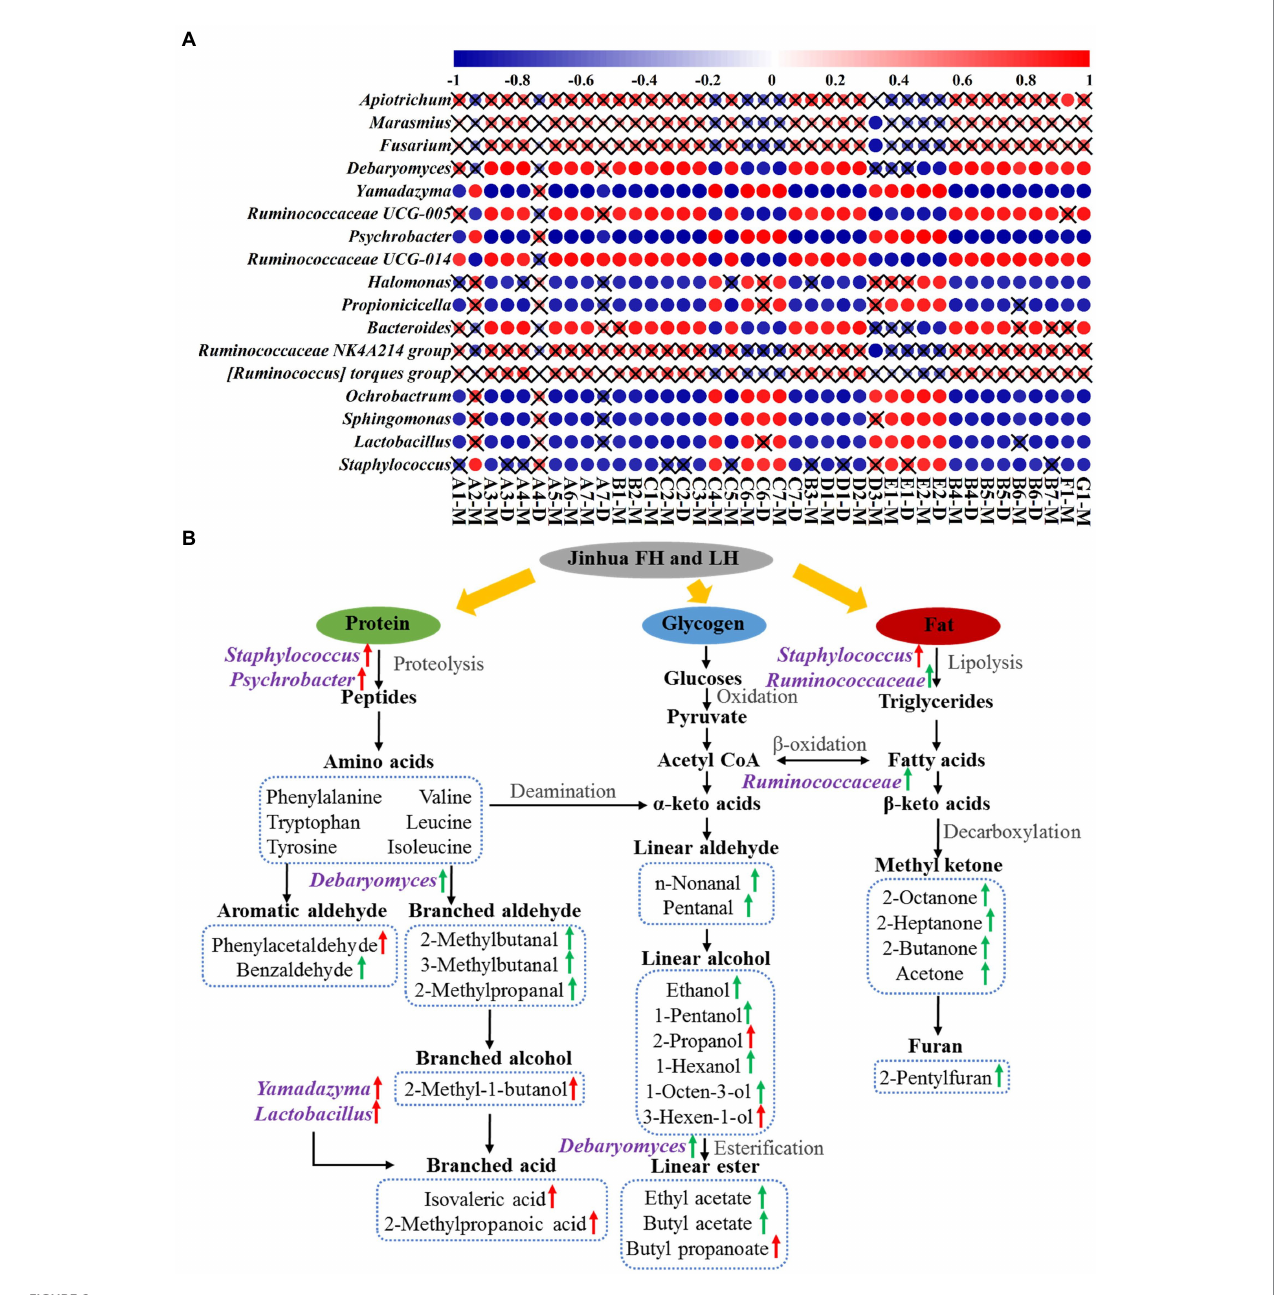
FIGURE 6 Pearson’s correlations (A) and potential pathways (B) between differential core microorganisms and distinct volatile flavor compounds. The color gradation and circle size in panel A represent the correlation coefficient (r value), while the pattern without a “×” symbol indicates a significant correlation ( p < 0.05). The green and red arrows in panel B indicate an up-regulation in FH and LH, respectively. A1, n-nonanal; A2, phenylacetaldehyde; A3, benzaldehyde; A4, pentanal; A5, 2-methylbutanal; A6, 3-methylbutanal; A7, 2-methylpropanal; B1, 3-octanone; B2, 6-methyl-5-hepten-2-one; B3, 2-octanone; B4, 2-heptanone; B5, 3-hydroxy-2-butanone; B6, 2-butanone; B7, acetone; C1, 1-octen-3-ol; C2, 1-pentanol; C3, ethanol; C4, 2-propanol; C5, 1-hexanol; C6, 3-hexen-1-ol; C7, 3-methyl-1-butanol; D1, ethyl acetate; D2, butyl acetate; D3, butyl propanoate; E1, isovaleric acid; E2, 2-methylpropanoic acid; F1, 2-pentylfuran; G1, dimethyl disulfide; M, monomer; D,